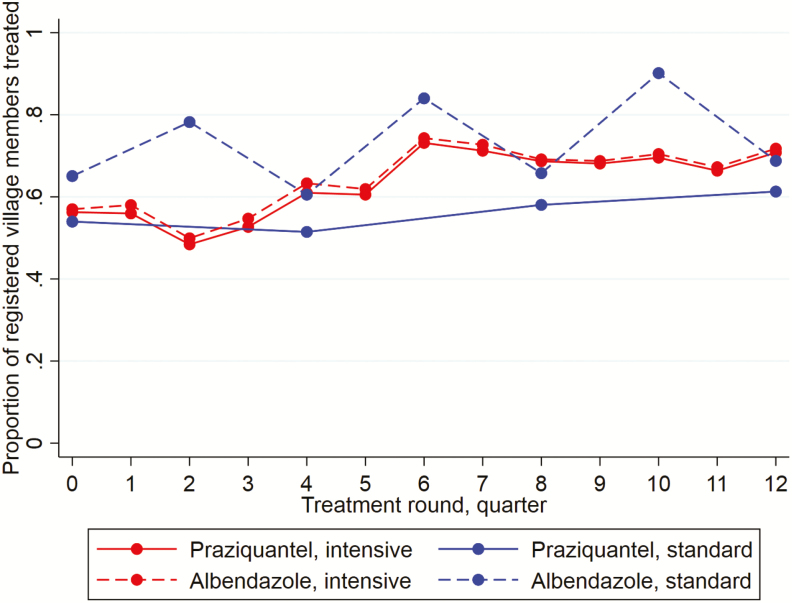
Praziquantel and albendazole treatment coverage, by trial arm and treatment round.